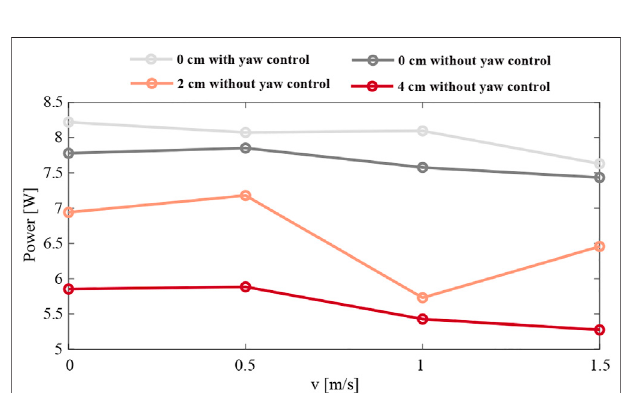
FIGURE 16 | The average power consumption of the robot fl ying in a side-windwithvariouswindspeeds,andinfourdifferentcon fi gurations:witha 0 cm mass displacement with and without yaw control (light and dark grey, respectively),andwithoutyawcontrolandamassdisplacementof2and 4 cm (orange and red, respectively). The average power consumption was determined during a 5 s time window in which the robot transitioned from sideways fl ight to forward fl ight in the wind